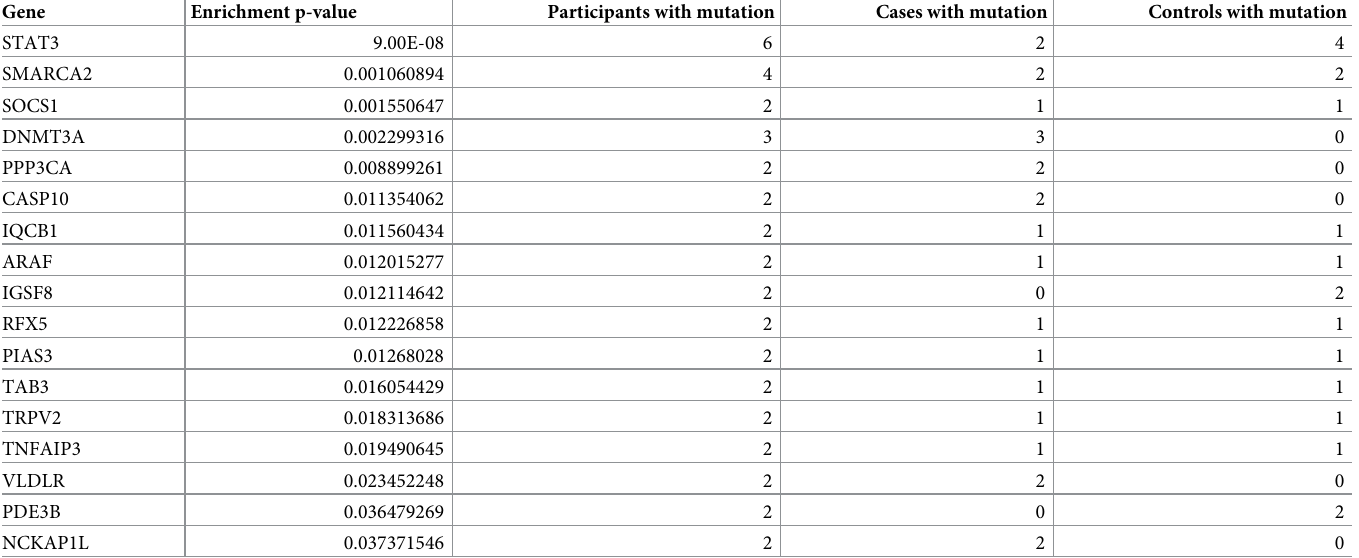
Table 3. Genes enriched with somatic mutations.